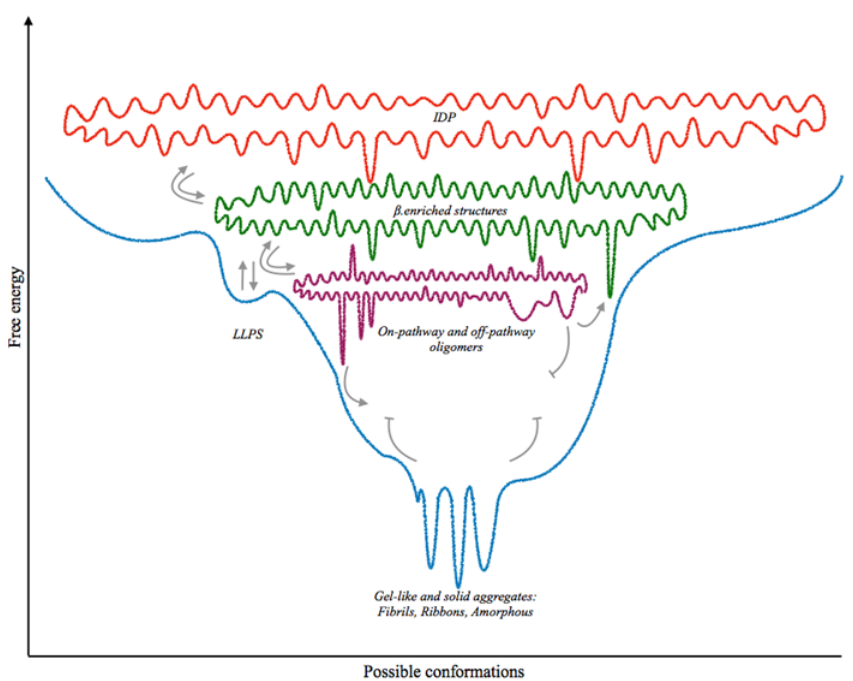
Figure 1. Illustration of the energetic landscape of IDPs. Model of energetic landscape of intrinsically disordered proteins plotted as a function of free energy. Unstructured IDPs (in red) fluctuate among multiple structural states with slightly different values of free energy. Structural transition to lower free energy states involves the formation of β -enriched structures (in green). The process is reversible (gray arrows) and may depend on overlapping energetic levels. Interaction among β -structures leads to oligomers (purple). LLPS may achieved at this stage (blue line depicting the overall trend of the aggregation pathway).These structures may be on pathway for the transition to stable, solid aggregates, or may be off-pathway (depicted as wider holes) which are more stable and cannot proceed further in the path towards aggregation, but may revert back to their monomeric form (indicated by the grey arrows). The final stage of aggregation (blue) consists of solid aggregates such as fibrils, ribbons and amorphous aggregates, which represent the absolute minimum of free energy a protein can